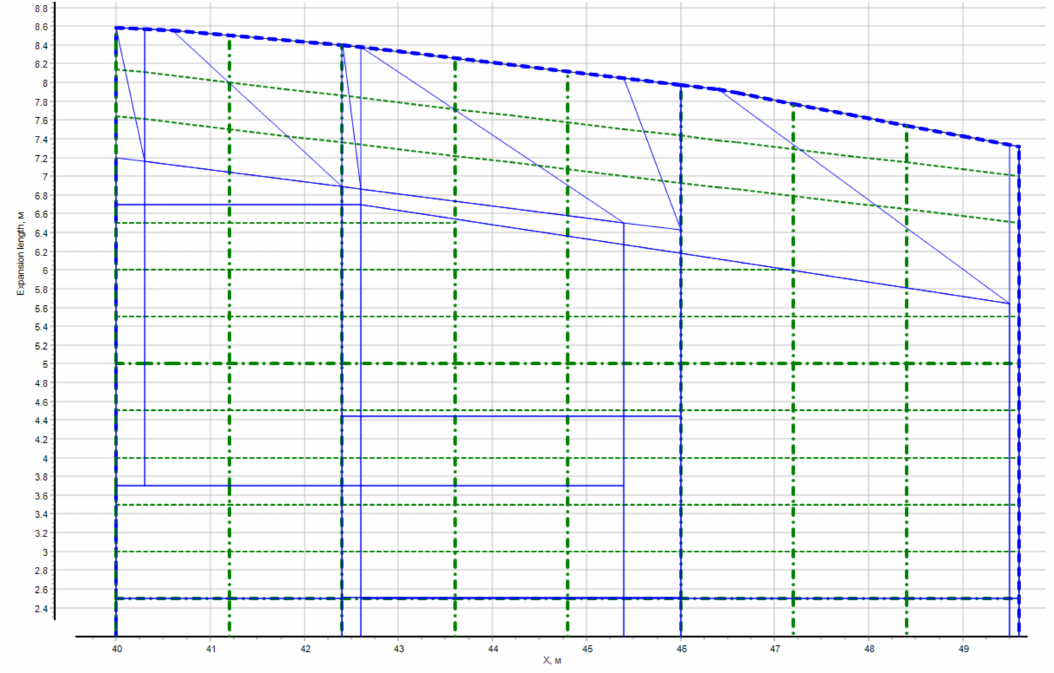
Figure 17. Incorrect generation of plate contours due to the partial coincidence of one or two faces of the cutting polygon (contour of the deck floor) and the faces of the cut polygon (contours of deck plates). The blue lines show a large number of incorrectly generated plate